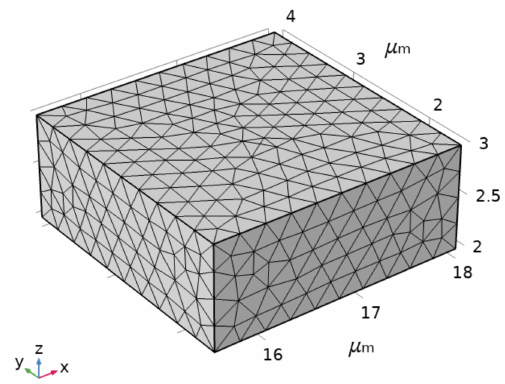
Figure 4. The meshing of the geometric model.